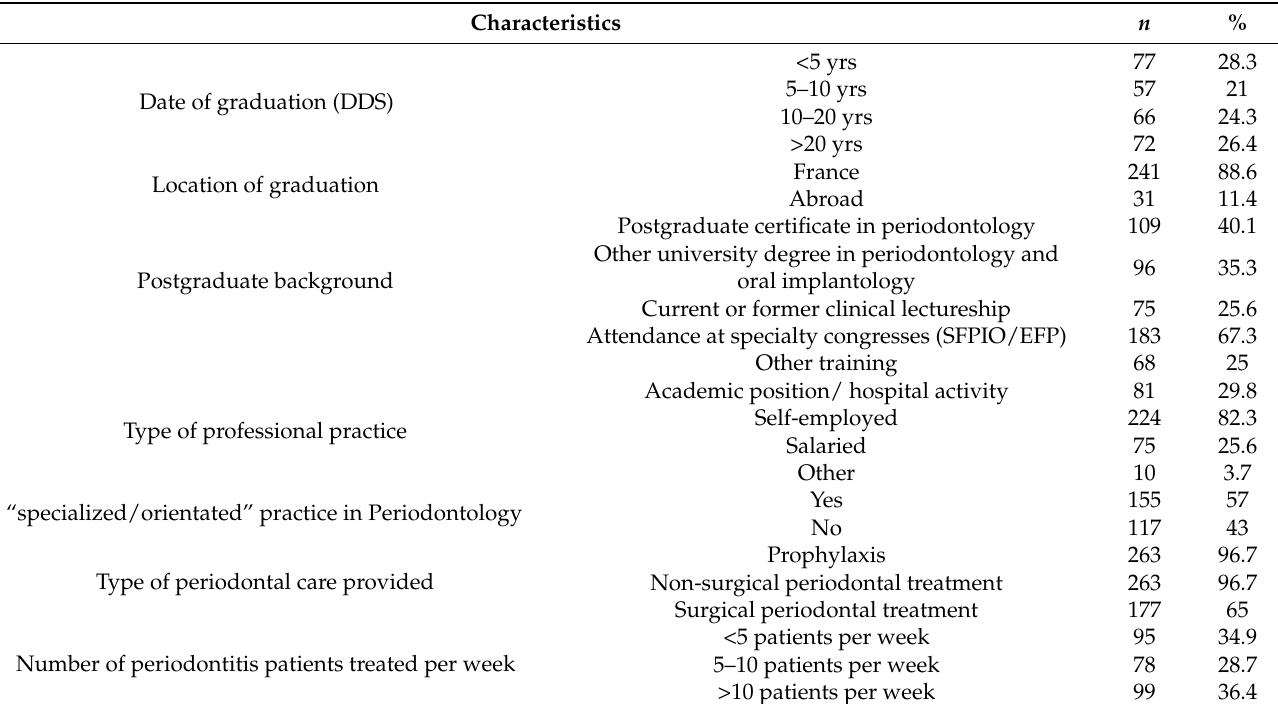
Table 1. Characteristics of